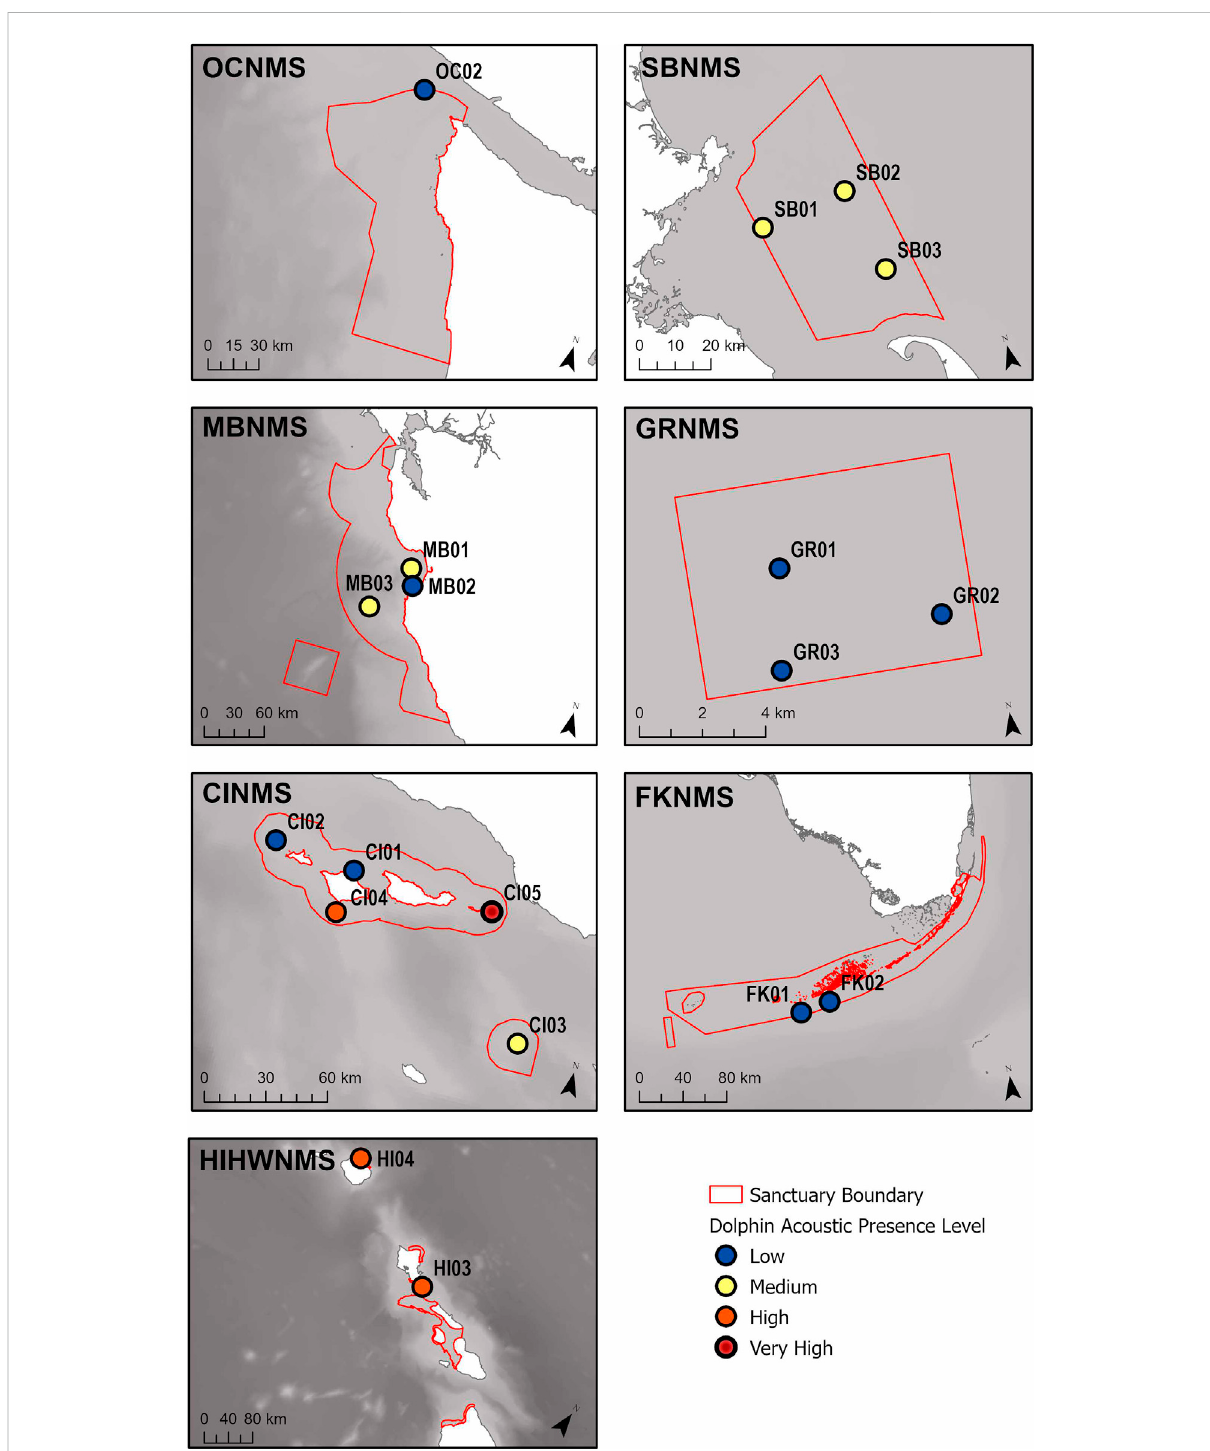
FIGURE 5 Amapoftherelativepercentdelphinidacousticpresenceclassi fi edintofourlevels(low,medium,high,veryhigh),foreachrecordingsitewithin each sanctuary. The sanctuaries represented are the Hawaiian Islands Humpback Whale National Marine Sanctuary (HIHWNMS), Olympic Coast National Marine Sanctuary (OCNMS), Monterey Bay National Marine Sanctuary (MBNMS), Channel Islands National Marine Sanctuary (CINMS), Stellwagen Bank National Marine Sanctuary (SBNMS), Gray ’ s Reef National Marine Sanctuary (GRNMS), and the Florida Keys National Marine Sanctuary (FKNMS), and are outlined in